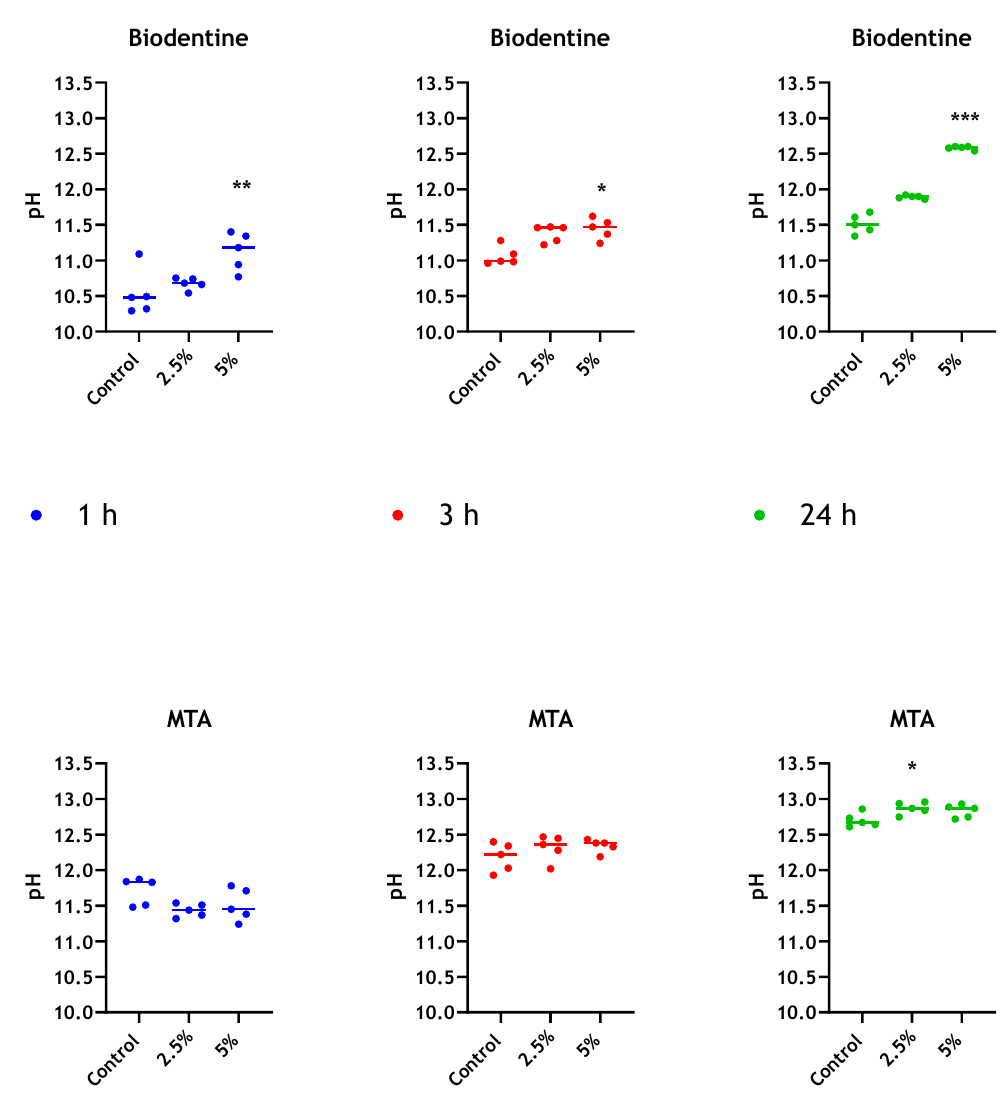
Figure 6. pH evaluation of leachate from different bioceramics. pH values for distilled water in contact with MTA and Biodentine + 2.5 wt% and 5% wt% CNPs, were determined at 1 h, 3 h and 24 h. Unmodified materials were used as controls. Data were analysed by Kruskal–Wallis with Dunn’s tests. Statistically significant differences between the control and each time point are presented as * p < 0.05, ** p < 0.01 and *** p < 0.001.